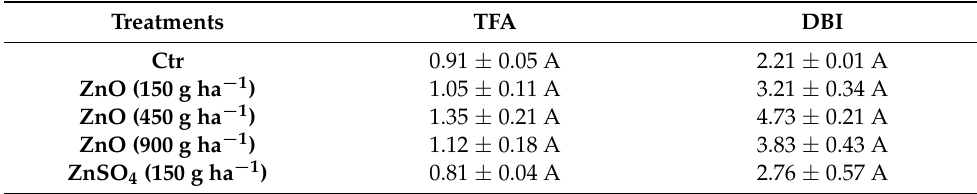
Table 4. Mean values ± SE (n = 3) of total fatty acid content (TFA g/100 g) and insaturation (DBI, A indicates the absence of significant differences between treatments (statistical analysis using the single-factor ANOVA test, p ≤